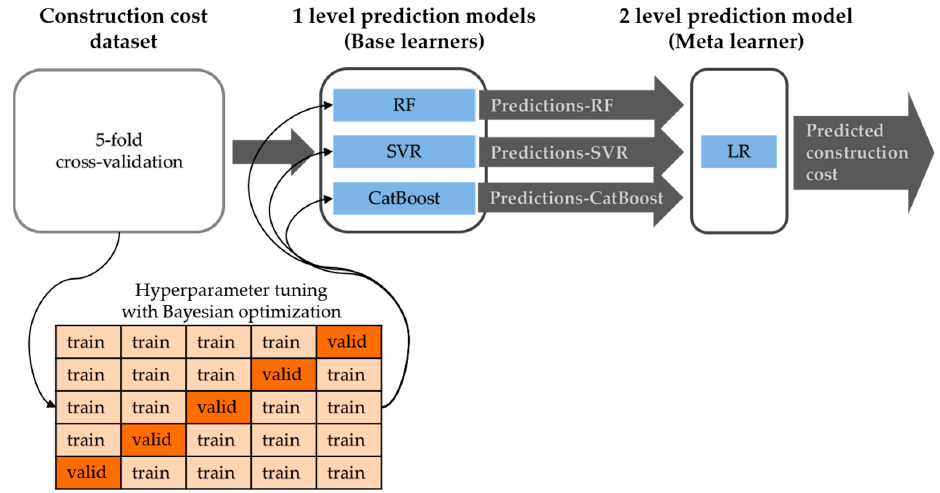
Figure 1. Proposed stacking model structure.